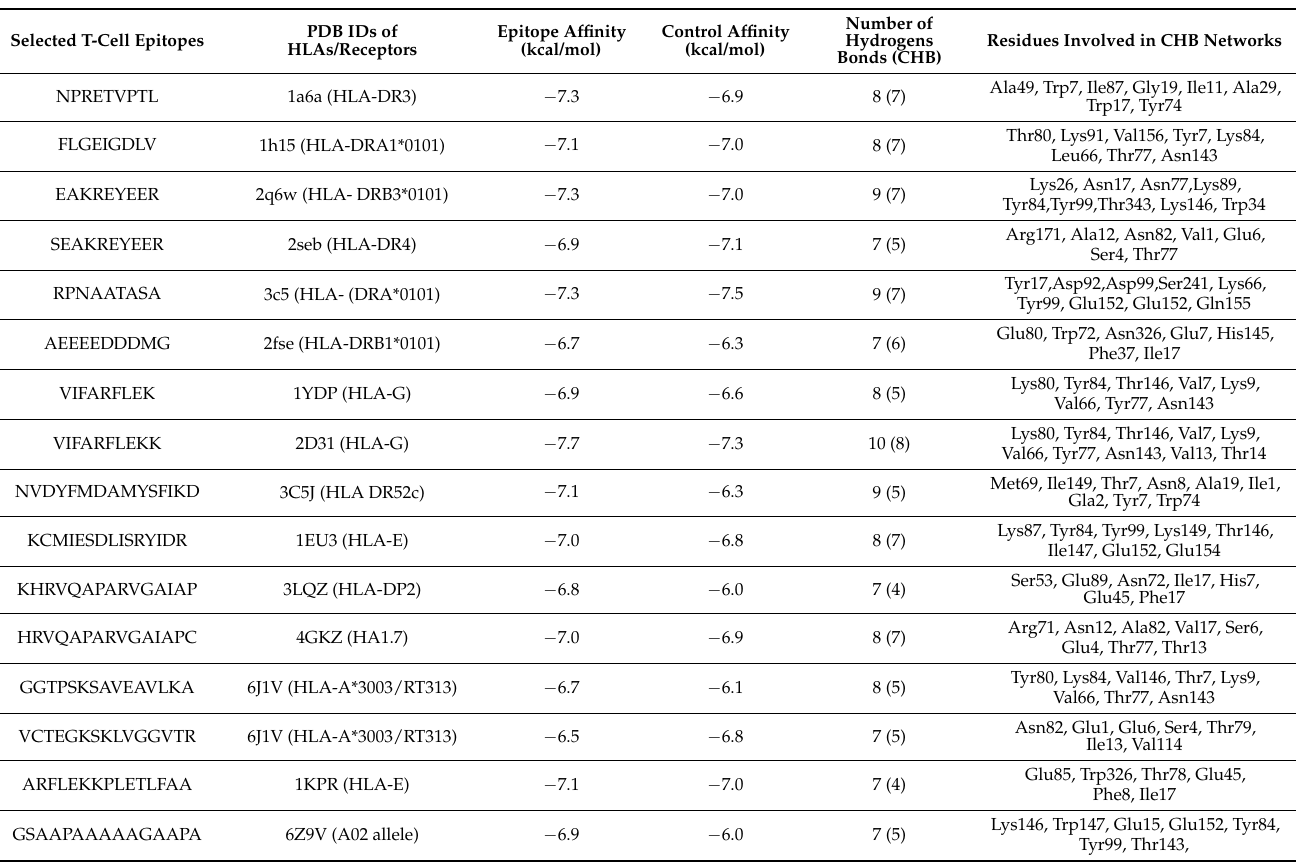
Table 5. List of residues that generate hydrogen bonds with epitopes, binding affinities, interactions, and docking alleles.